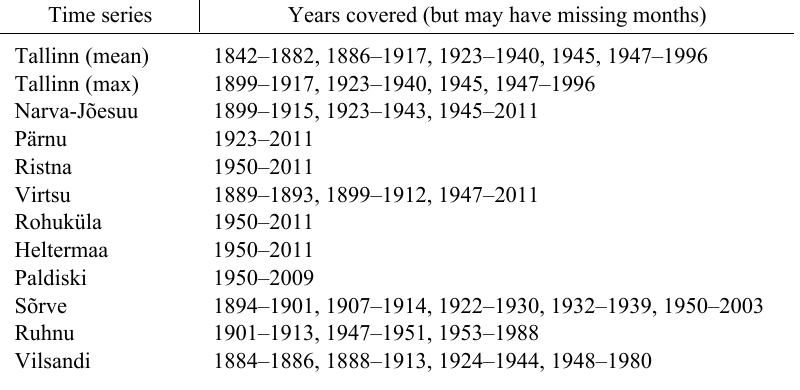
Table 1. Monthly time series of the mean and extreme sea level available for the investigated tide